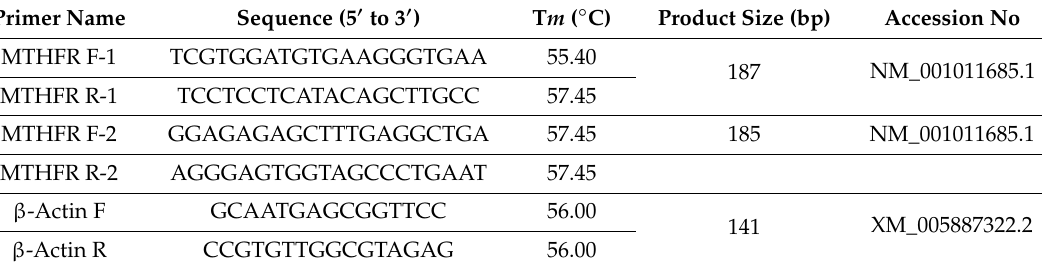
Table 2. Primer sequences of target and house-keeping